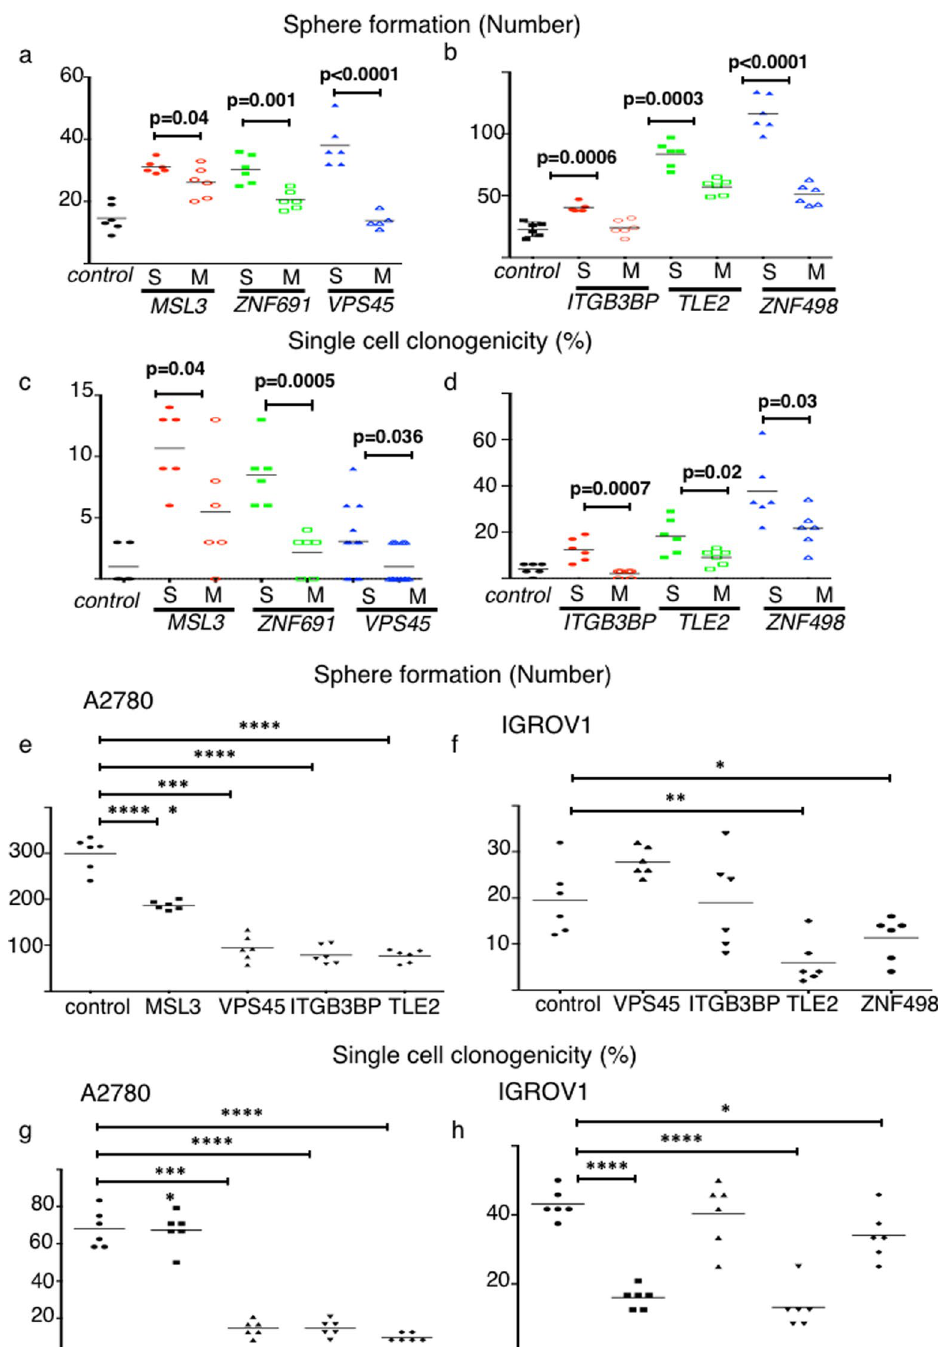
Figure 3. Six genes regulate cancer stem cell (CSC) phenotypes as well as the SP fraction. Sphere formation and single cell clonogenicity were assessed. ( a – d ) Newly generated SP cells harbor a CSC phenotype. ( a , b ) Sphere forming ability. Data from CH1-shcontrol and sh-target gene cells are shown in Fig. 3a; data from SKOV3-shcontrol and sh-target gene cells are shown in Fig. 3b. The number represents spheres larger than 200 µ m (n = 6 replicates). ( c , d ) Single cell clonogenicity. Expanded clone colonies were counted and the proportion of cells capable of colony formation was calculated (n = 6 replicates). Data from CH1-shcontrol and sh-target gene cells are shown in Fig. 3c; data from SKOV3-shcontrol and sh-target gene cells are shown in Fig. 3d. ( e – h ) Overexpression of MSL3 , VPS45 , ITGB3BP , TLE2 , ZNF498 decreased sphere formation and single cell clonogenicity. ( e , f ) Sphere formation. Data from A2780-control and ORF-target gene cells are shown in Fig. 3e. Data from IGROV1-control and ORF-target gene cells are shown in Fig. 3f. The number of spheres larger than 200 µ m is depicted. * p < 0.05, ** p < 0.01, *** p < 0.001, **** p < 0.0001. ( g , h ) Single cell clonogenicity. Expanded clones were counted and the proportion of cells capable of colony formation was calculated. Data from A2780-control and ORF-target gene cells are shown in Fig. 3g. Data from IGROV1-control and ORF-target gene cells are shown in Fig. 3h. * p < 0.05, ** p < 0.01, *** p < 0.001, **** p <